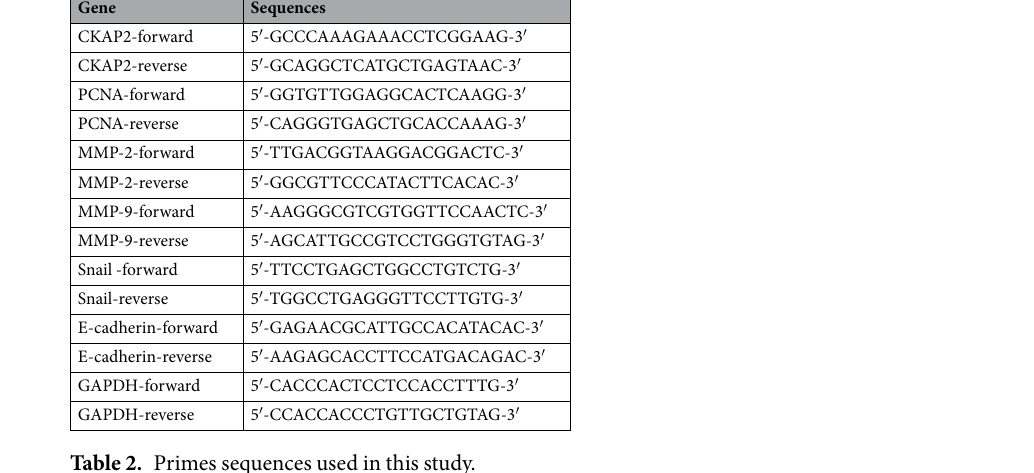
Table 2. Primes sequences used in this